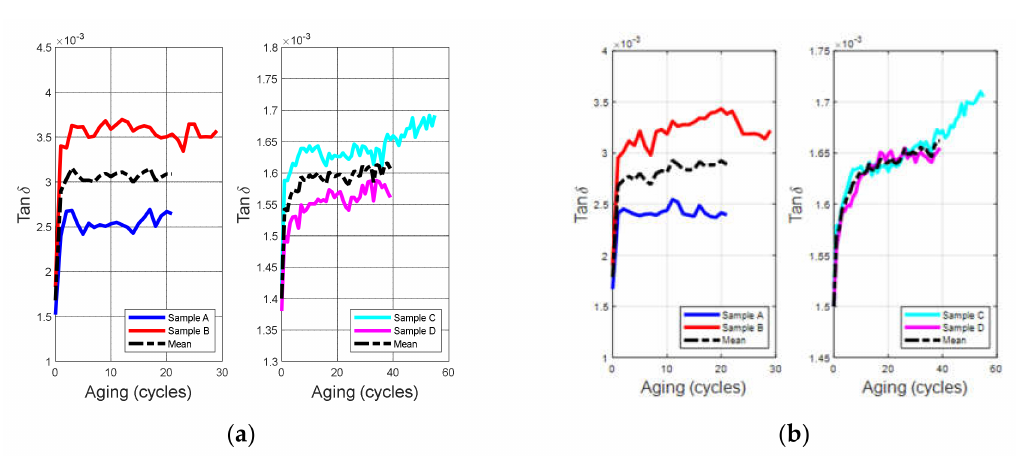
Figure 10. Tan δ measurement results for 50 Hz ( a ) 2 kV and ( b ) 12